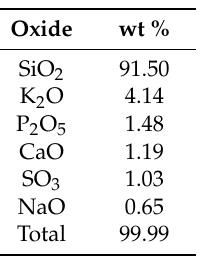
Table 5. Chemical composition of RHA.